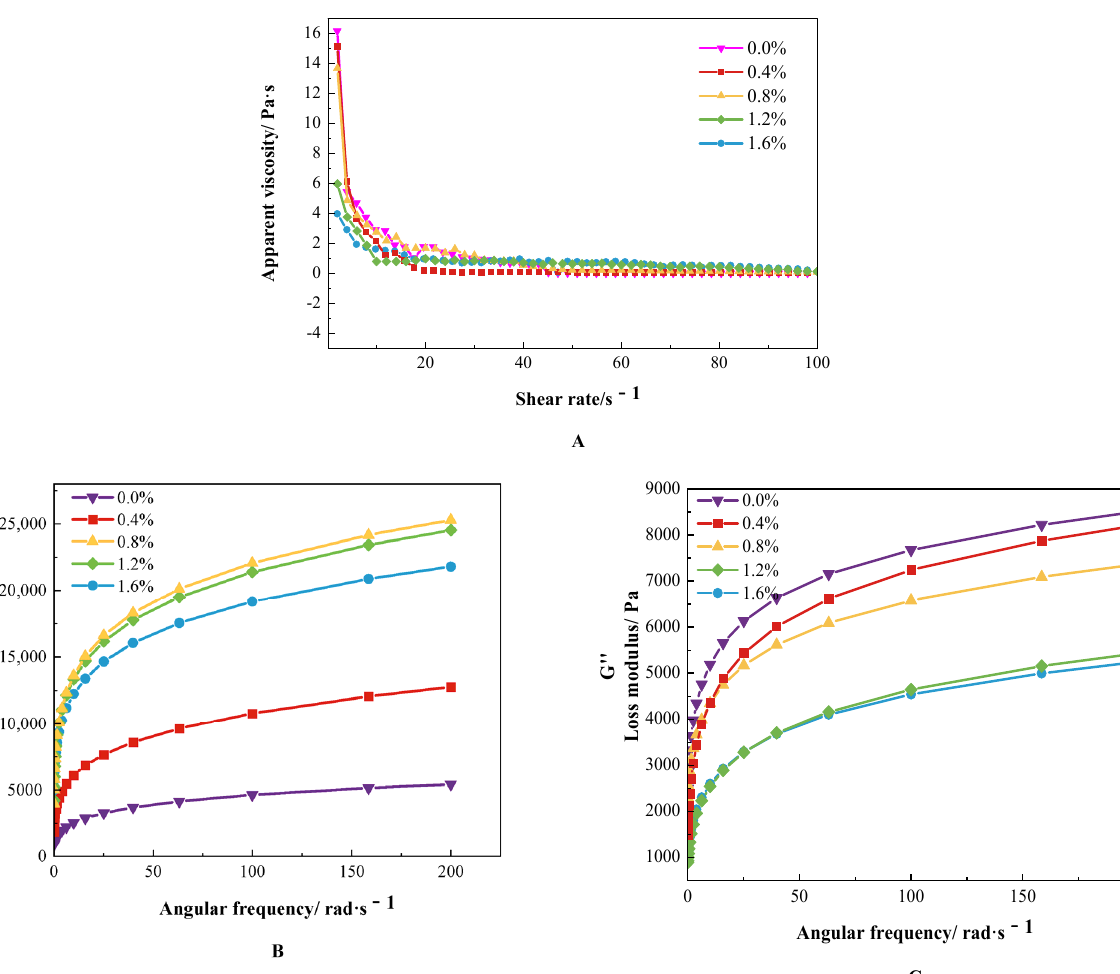
Figure 2. ( A ) E ff ect of added apple polyphenols on the apparent viscosity curves of processed cheese; ( B , C ) E ff ect of added apple polyphenols on the dynamic rheological properties of processed cheese: ( B ) storage modulus (G ′ ) and ( C ) loss modulus (G ″ ).